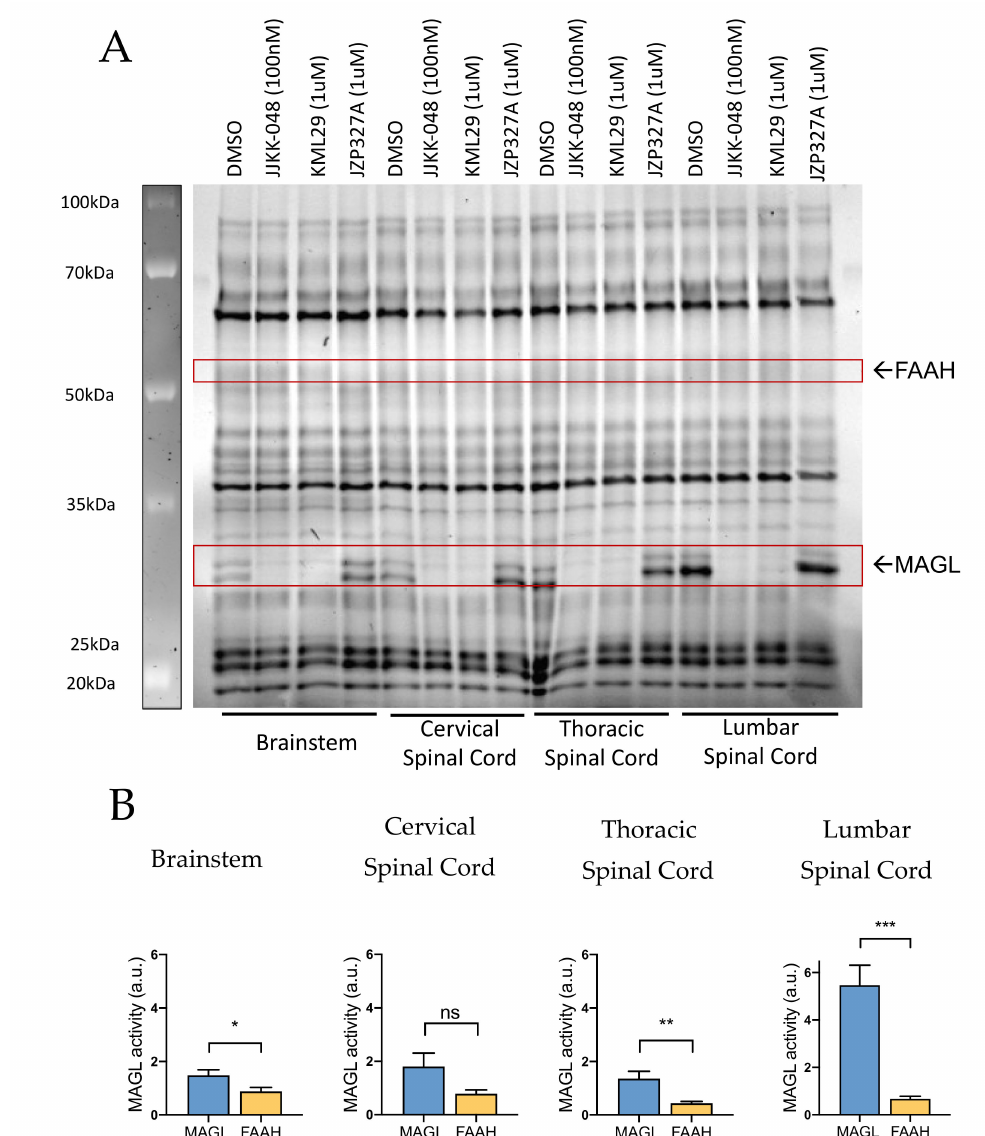
Figure 2. Competitive gel-based ABPP reveals variable MAGL and FAAH activities in rat brainstem and cervical, thoracic and lumbar spinal cord. ( A ) Brainstem and spinal cord proteomes were incubated for 1 h with vehicle (DMSO), MAGL inhibitors JJKK-048 (100 nM) and KML29 (1 µ M) and FAAH inhibitor JZP327A (1 µ M), and then labeled with the fluorescent probe TAMRA-FP, as indicated in Materials and Methods. FAAH and MAGL were identified based on selective inhibition and their expected molecular weights. Note that basal MAGL activity was high in the lumbar spinal cord but less intense in samples of the brainstem, cervical and thoracic spinal cord. Based on this analysis, FAAH activity was not found in samples of the brainstem and spinal cord. ( B ) Histograms comparing the basal activity of MAGL and FAAH in the brainstem and different spinal cord parts. Basal MAGL activity was approximately 2-fold higher compared to that of FAAH in brainstem, and ~4-fold higher in thoracic spinal cord. In the lumbar spinal cord, MAGL activity was ~8-fold higher than of FAAH. Unpaired t -test, * p < 0.05, ** p < 0.01, *** p < 0.001, ns = nonsignificant, n = 11 (BS, cSC) and n = 8 (tSC,